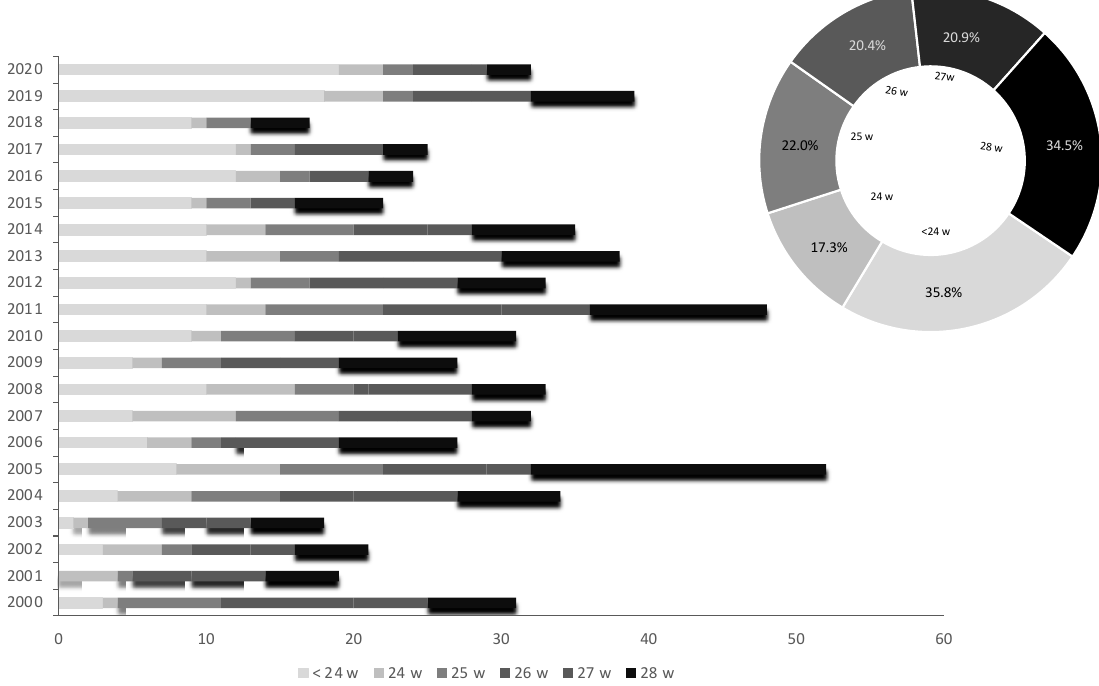
Figure 2. Yearly distribution of the sample according to gestational age at diagnosis of PPROM.